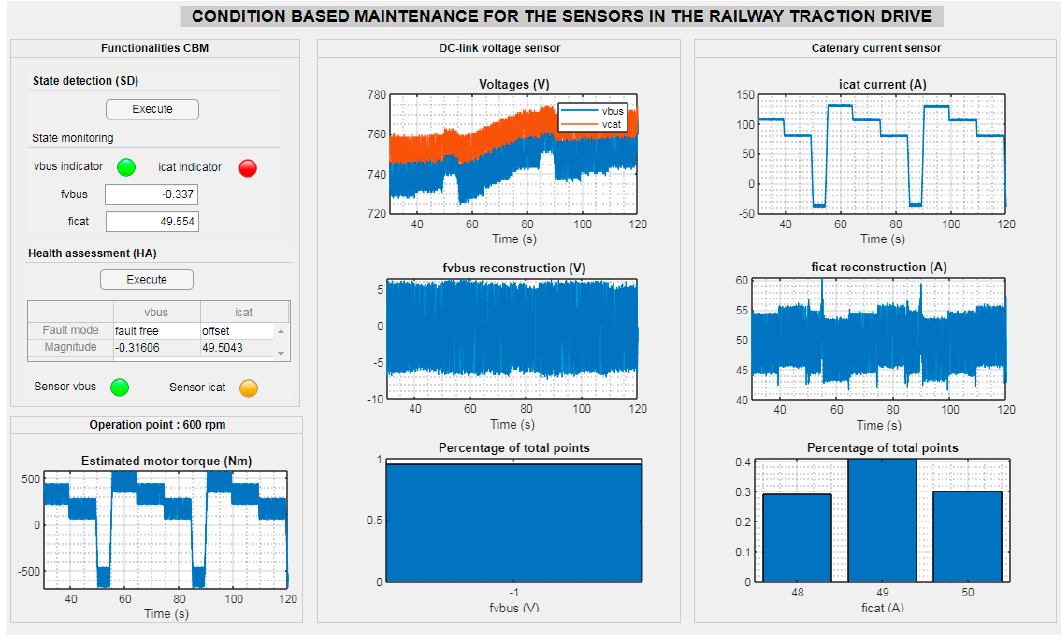
ff set fault of 50 A injected in catenary current